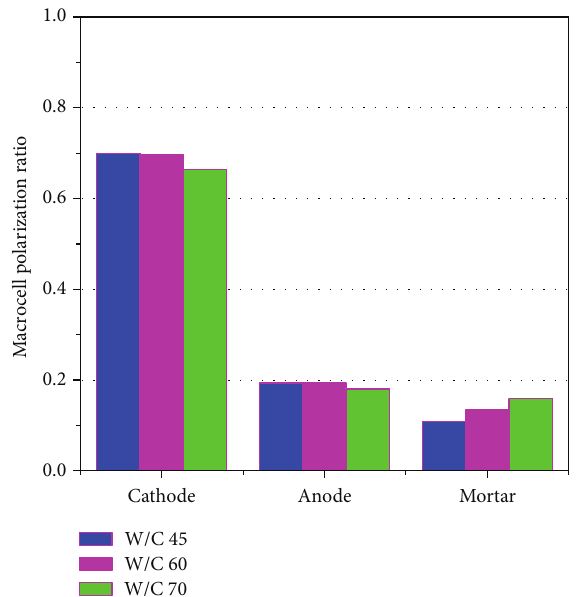
Figure 9: Effect of water-cement ratios on the macrocell polariza- tion ratios of cathode and anode.